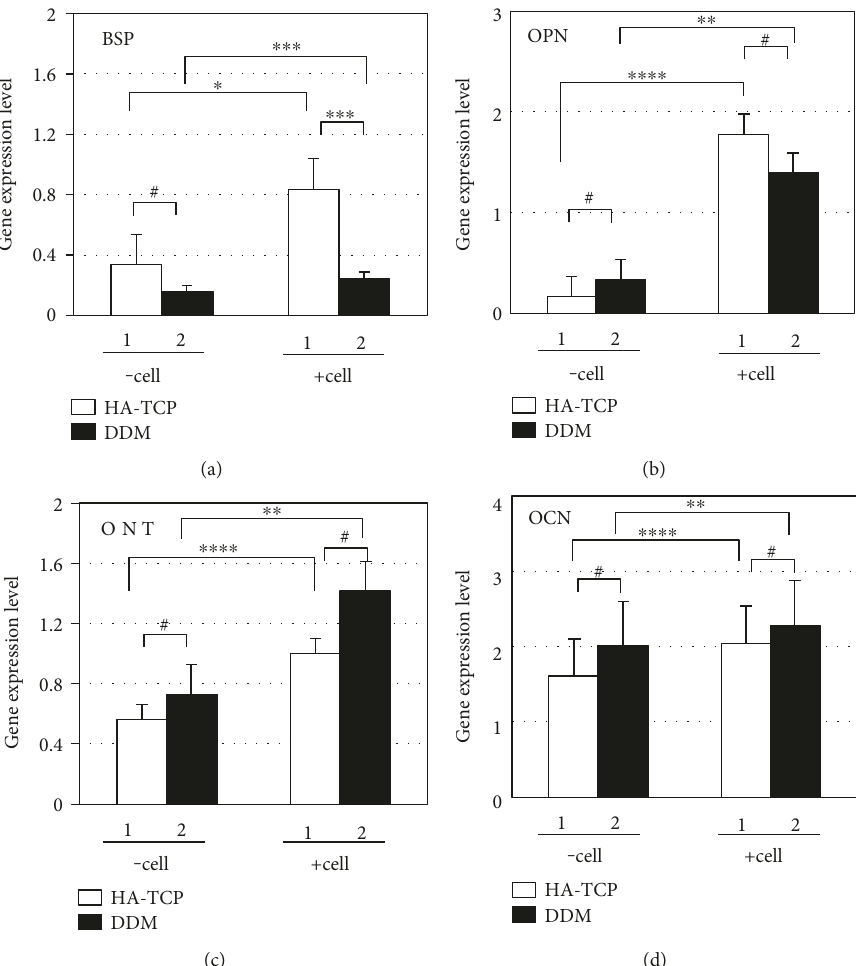
Figure 5: Analyses of gene expression of osteoblast markers in transplants. Fibrin blocks of HA-TCP/hDPSCs or DDM/hDPSCs were transplanted in athymic nude mice, and total RNA was isolated from transplant tissues after 8 weeks. Gene expressions of BSP (a), OPN (b), ONT (c), and OCN (d) were detected by qRT-PCR. 1, transplants with HA-TCP with or without hDPSCs; 2, transplants with DDM with or without hDPSCs. Transplantations with and without hDPSCs indicated as – cell and +cell , respectively. Statistical analyses were carried out using Student ’ s t -test. ∗ p < 0 05 ; ∗∗ p < 0 01 ; ∗∗∗ p < 0 001 ; ∗∗∗∗ p < 0 0001 ; #, signi fi cant di ff erence not be